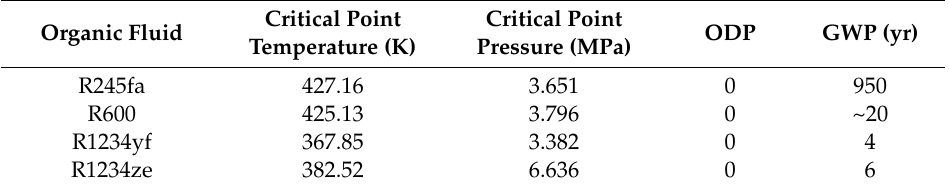
Table 1. Critical pressure and critical temperature, Ozone Depletion Potential (ODP) and Global Warming Potential (GWP) of the four working fluids that are examined in the present study